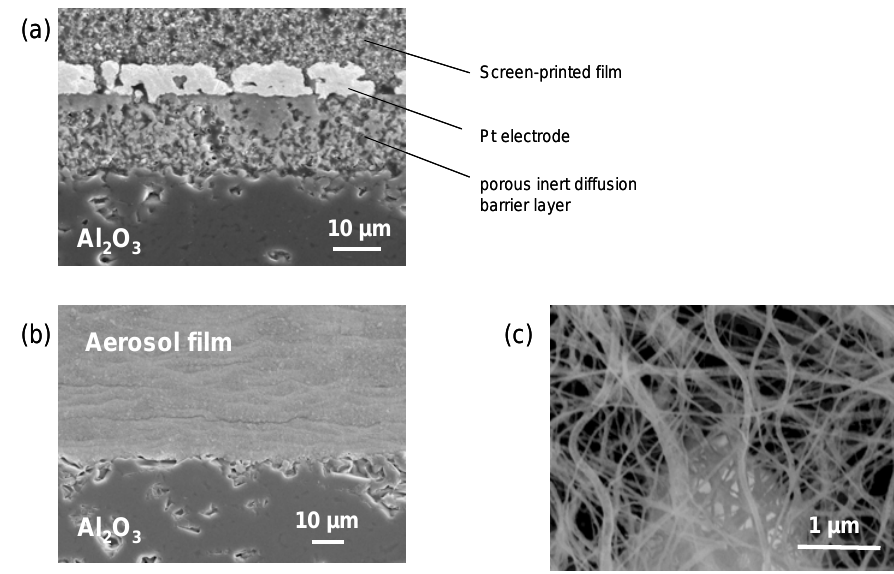
Figure 11. One sensing material, different microstructures: (a) Porous SrTi 1-x Fe x O 3- δ film prepared by conventional screen-printing. (b) Aerosol-deposited compact layer. (c) Fe O fiber structures obtained by SrTi 1-x x 3- δ